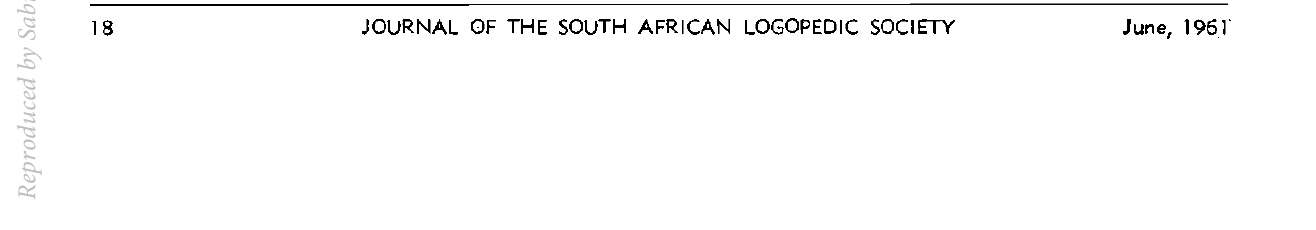
A drawing from a dissection of the eustachian tube showing its relationship to the middle ear space on one end and the nasopharynx on the other